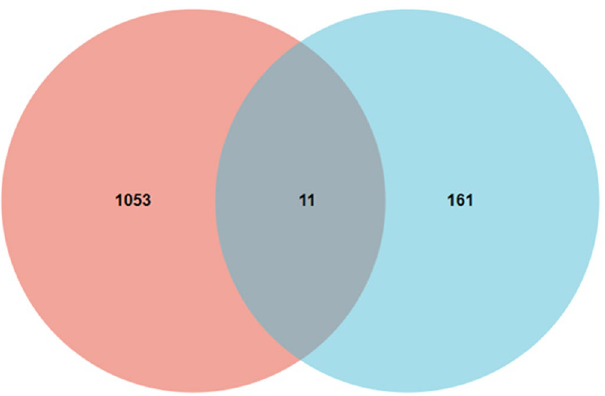
Figure 7. The Venn diagram demonstrating the relationship between ferroptosis genes and DEGs.